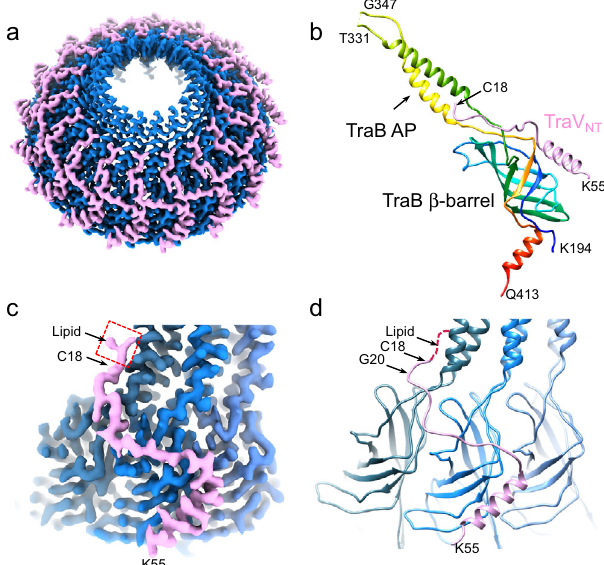
Fig. 3 Structure of central cone (CC). a Overview of the 2.95 Å CC from the pED208-carrying (WT) strain reconstructed with 17-fold symmetry imposed. The CC is composed of domains of TraB (blue) and TraV (pink). b The atomic model of the β -barrel and AP domains of TraB (residues K194- Q413) in rainbow color, with the N-terminal domain of TraV (TraV NT , residues C18-K55) (pink). An AP fl exible loop (residues T332-I346) cannot be built in the model. c , d Interaction between the TraV NT domain and three adjacent TraB β -barrel domains visualized in densities and models, respectively. The red box in ( c ) shows a piece of lipid density connected to TraV